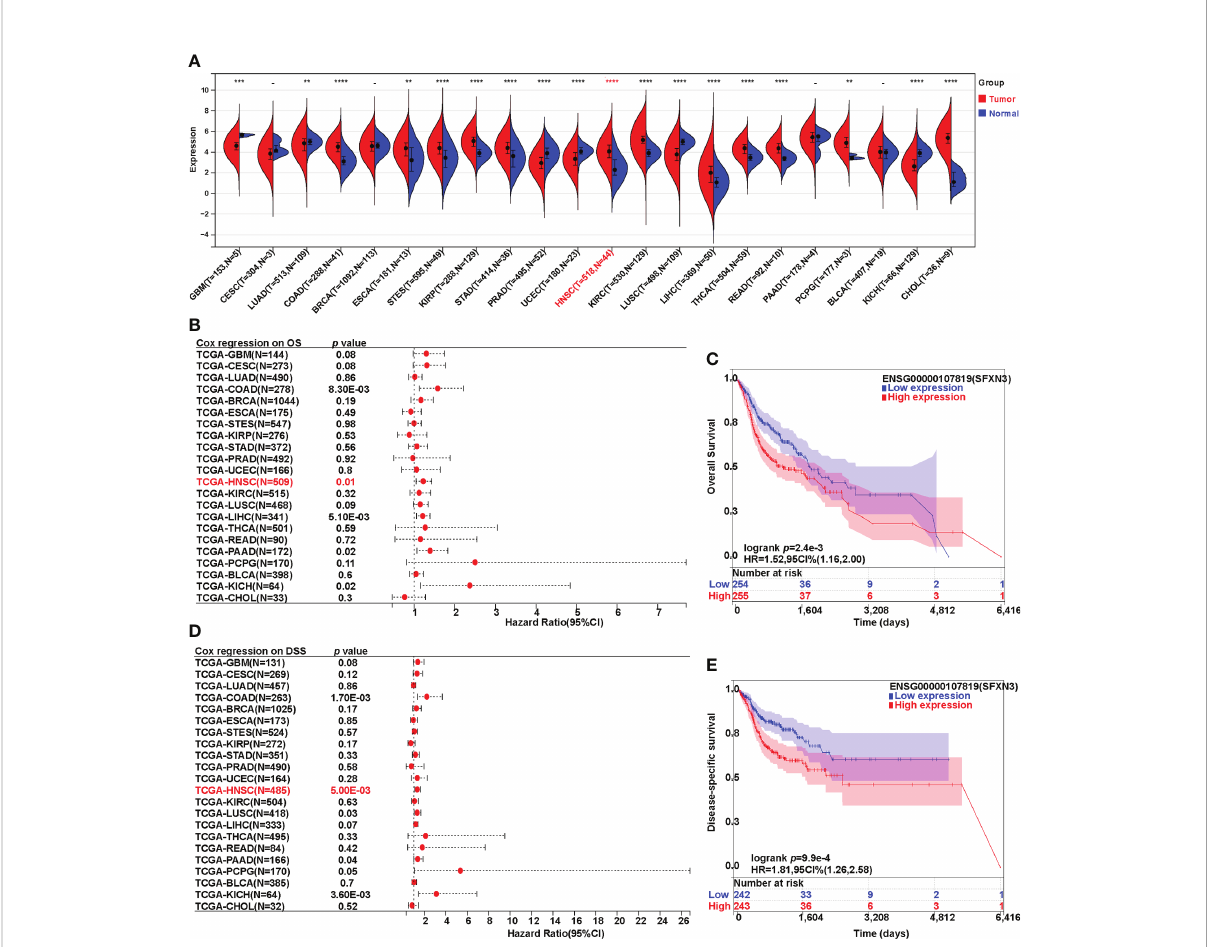
FIGURE 1 Expression analysis and survival analysis for SFXN3 in pan-cancer. (A) The expression of SFXN3 in pan-cancer based on TCGA cancer and normal data analyzed. (B) Cox regression analysis on overall survival was performed on SFXN3 expression in pan-cancer. (C) The overall survival (OS) analysis in patients with HNSC. (D) Cox regression analysis on disease-speci fi c survival (DSS) was performed on SFXN3 expression in pan-cancer. (E) The DSS analysis for SFXN3 expression in patients with HNSC determined. -: no signi fi cant difference, ** p value < 0.01; *** p value < 0.001; **** p value <